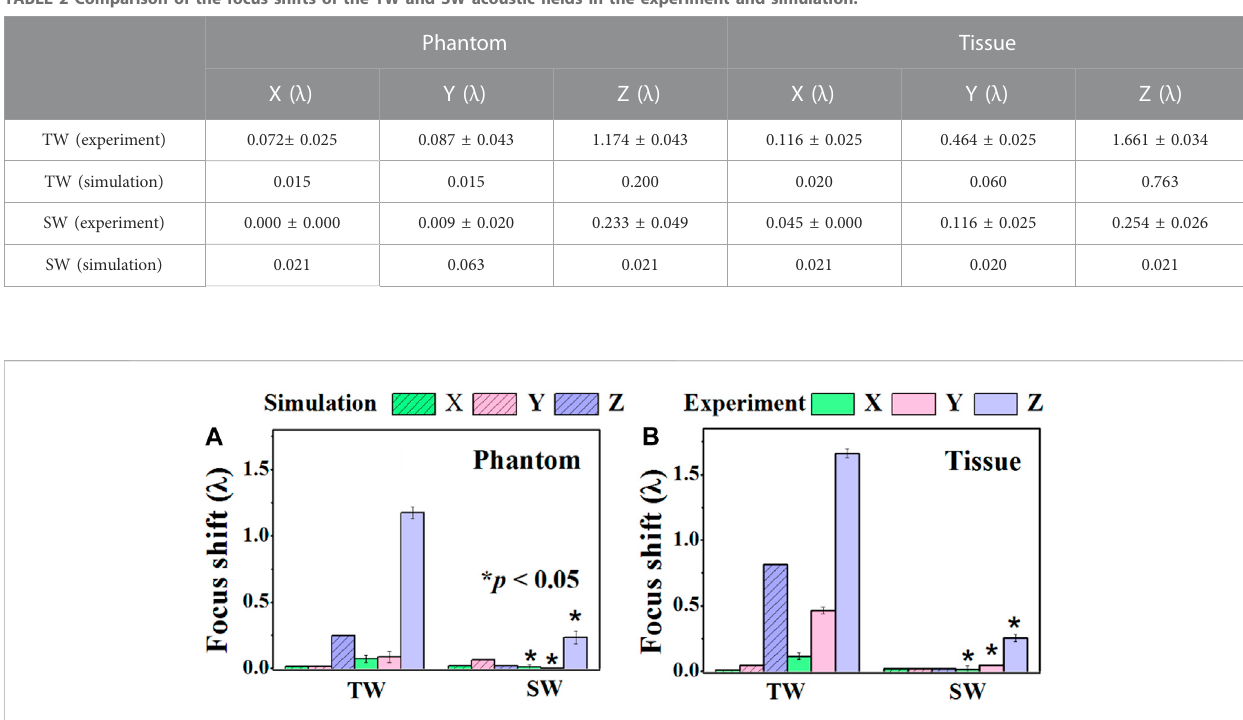
TABLE 2 Comparison of the focus shifts of the TW and SW acoustic fi elds in the experiment and simulation.